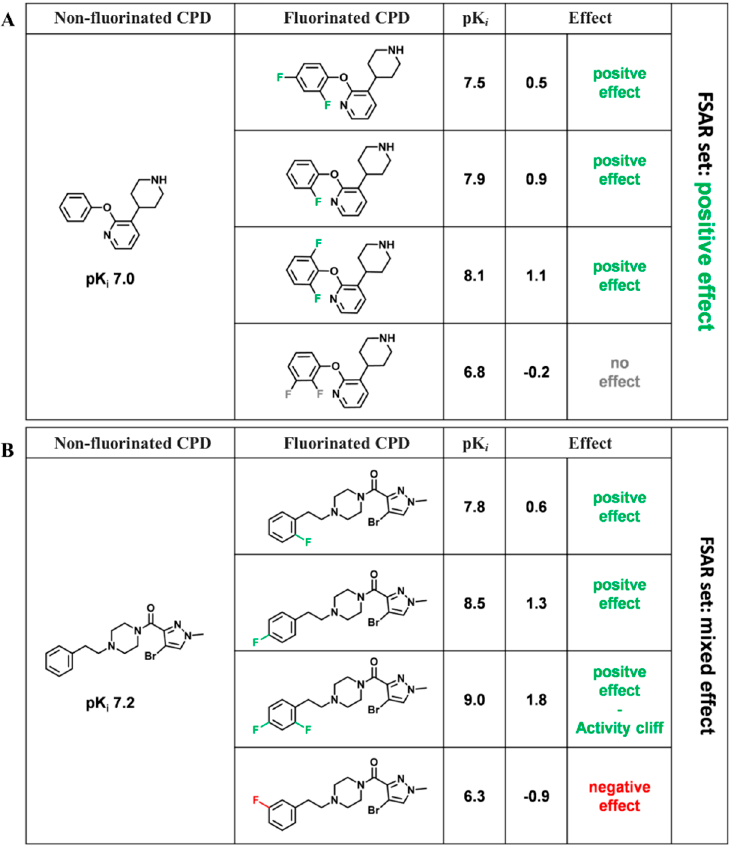
Figure 2. Potency effects. For two exemplary FSAR sets, the potency effect for each non-F (left)– fluorinated (middle) analogue pair and the resulting FSAR effects are given on the right. Potency values against serotonin 1a (5-HT1a) receptor ( A ) and serotonin 2a (5-HT2a) receptor ( B ) and Δ pPot are reported. As an AC criterion, a Δ pPot of 1.7 corresponding to a 50-fold difference in potency was applied.